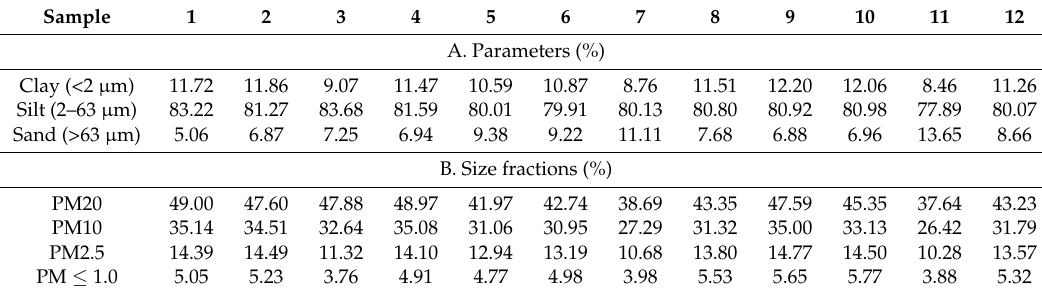
B. Size fractions